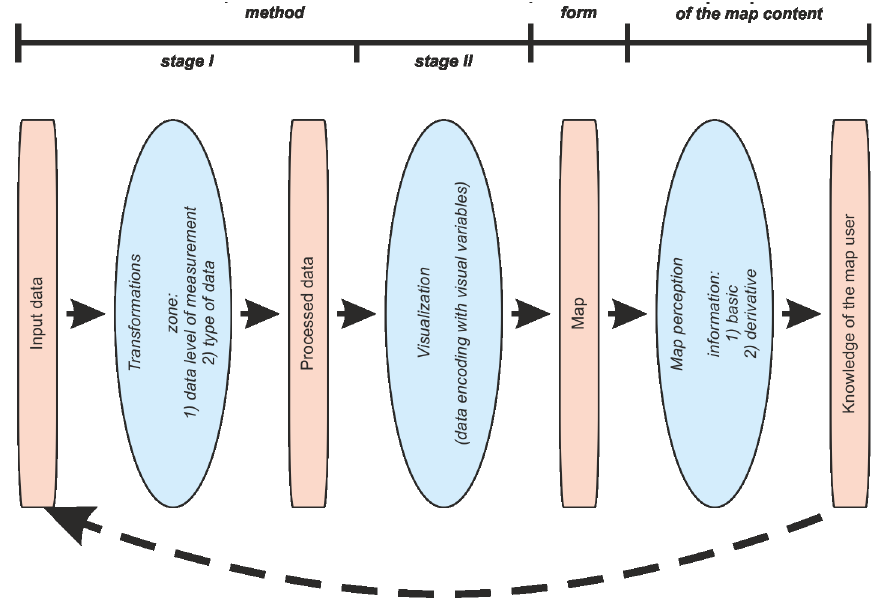
Fig. 1. The scheme of stages of the cartographic presentation method in comparison to the cartographic communication of information (the author’s own elaboration based on J. Korycka-Skorupa